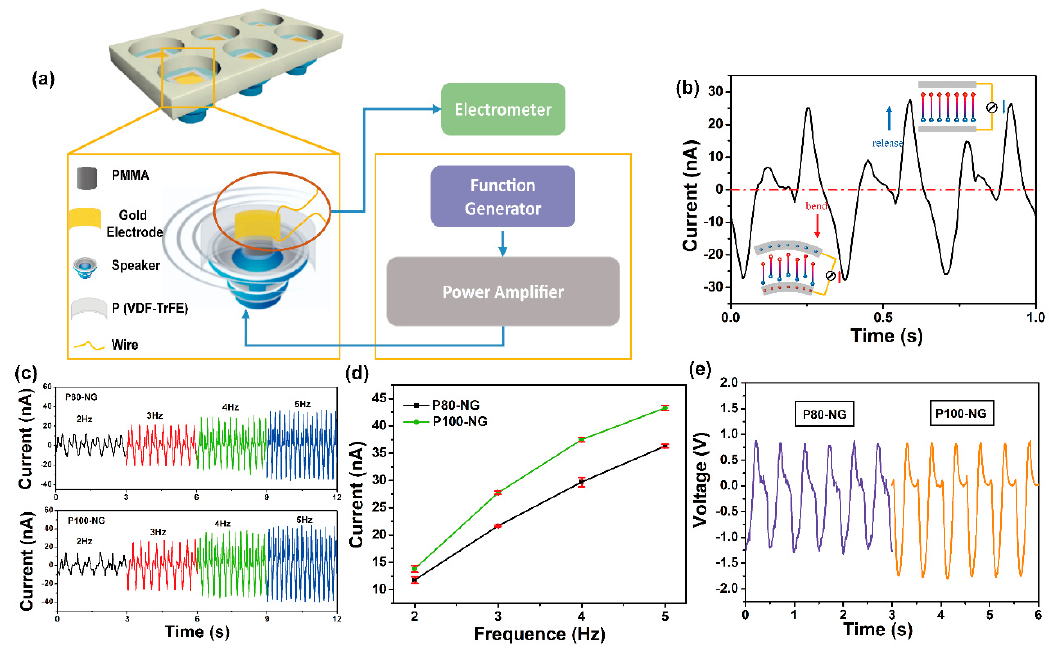
Figure 5. Effect of mechanical stimulus on electrical performances of different NGs. ( a ) Schematic diagram of the home-designed experimental shaker for providing periodic mechanical vibrations.